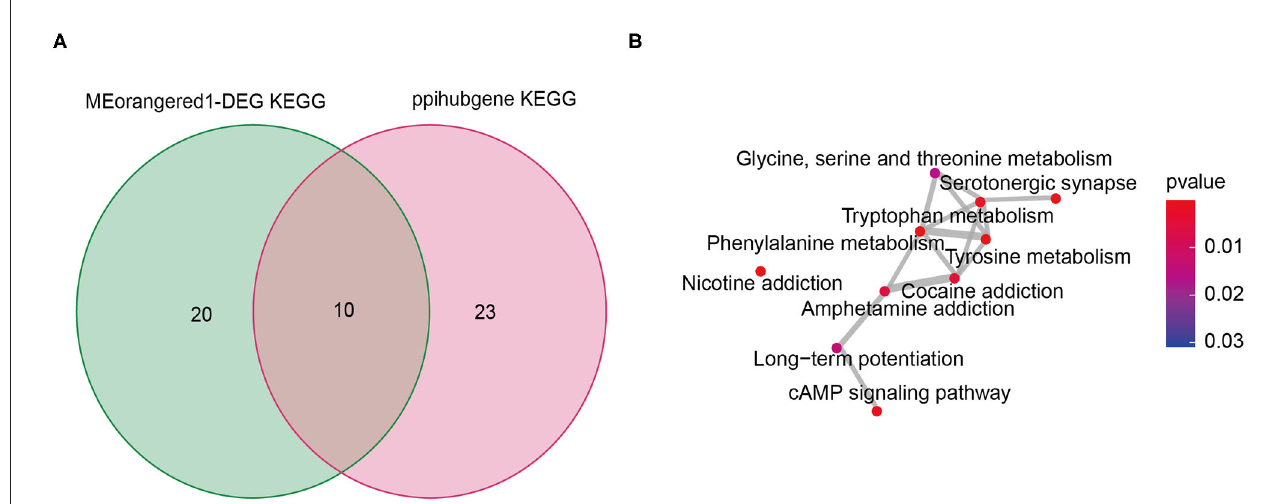
FIGURE 4 | The shared signaling pathway of KEGG enrichment analysis from intersection genes between DEG and the Meorangered1 modules and hub genes (A) . Crosstalk analysis of the shared signaling pathway (B) . division, differentiation and death (24, 25). By